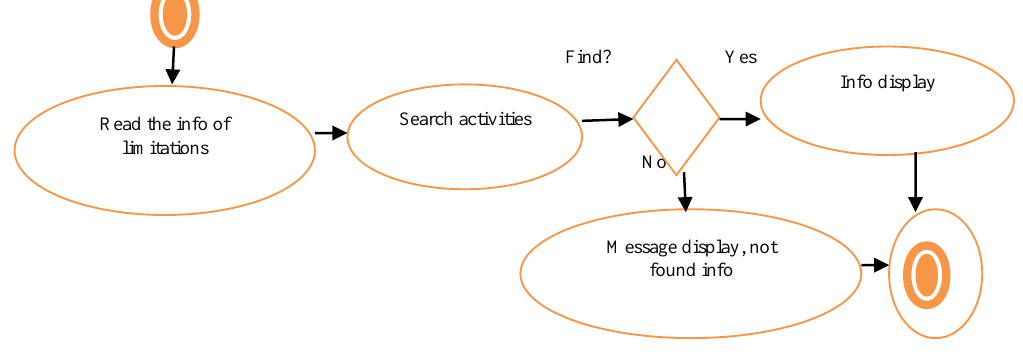
Figure 12. Planner model of search agent.